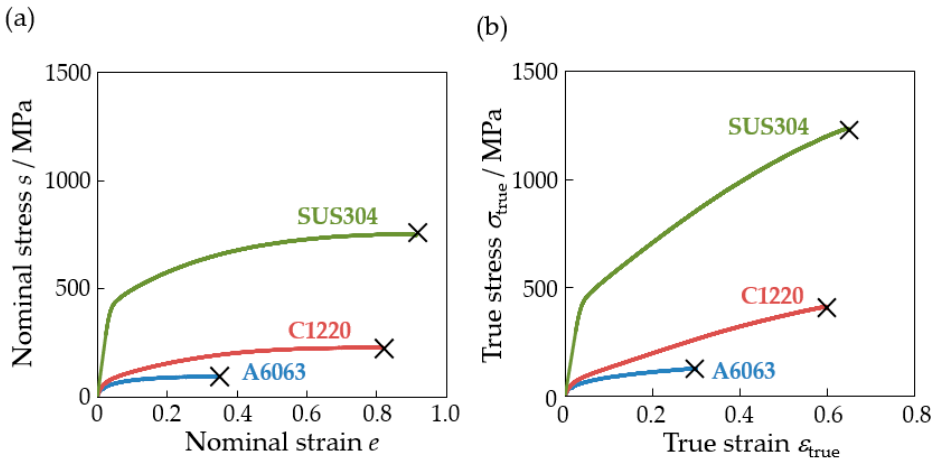
Figure 5. Results of the tensile test. ( a ) Nominal stress—nominal strain curves and ( b ) true stress—true strain curves. The symbol × indicates the fracture point.